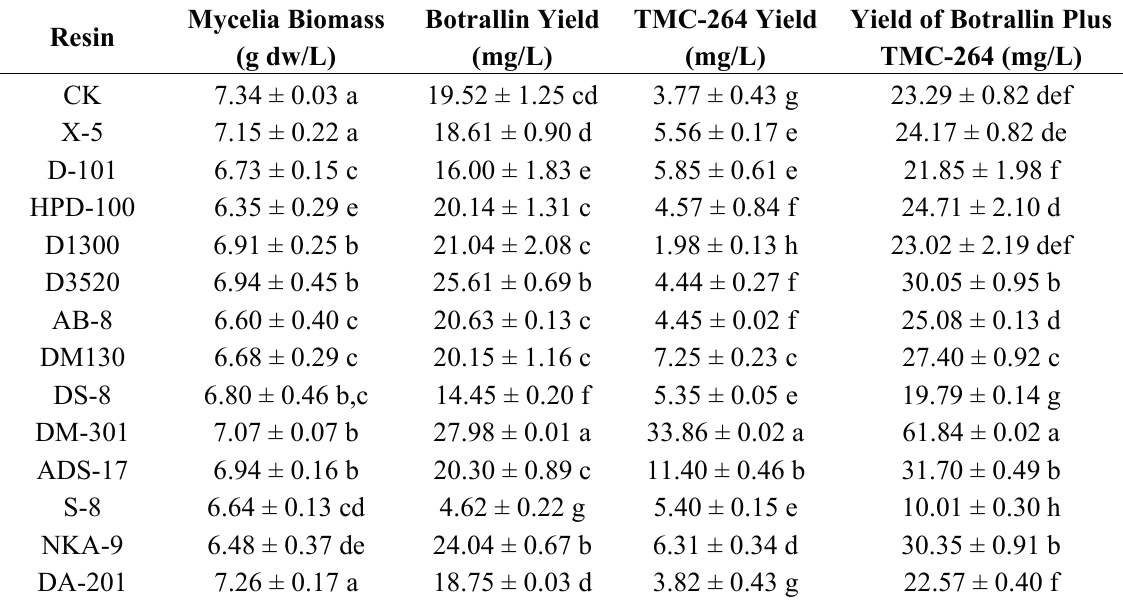
Table 1. Effects of the resins on mycelial growth, production of botrallin and TMC-264 in liquid culture of Hyalodendriella sp.